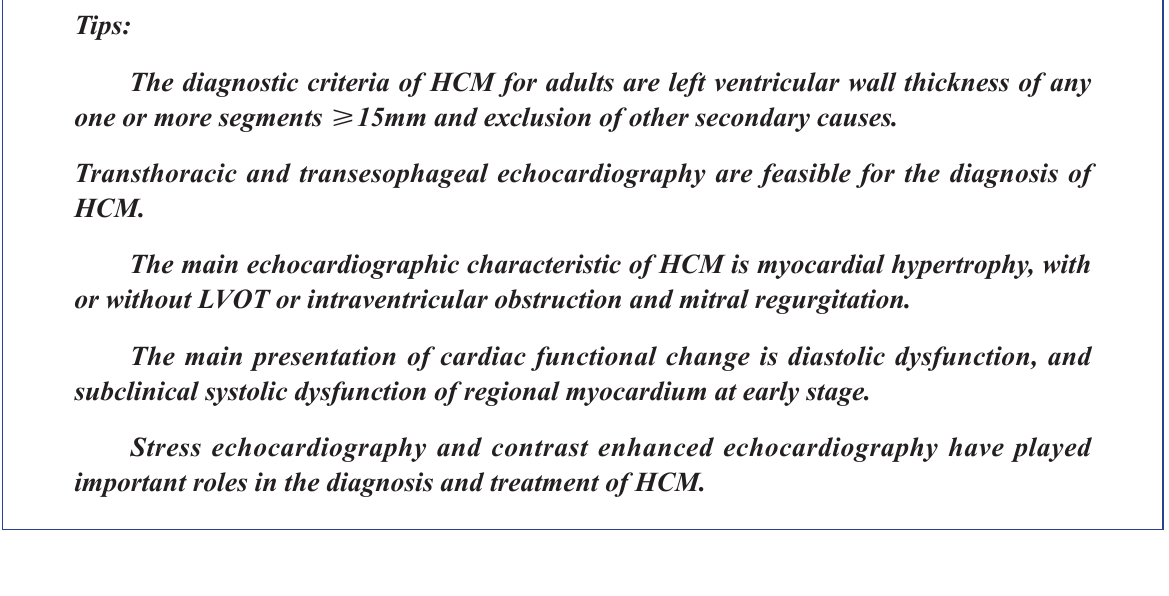
Table 2 Classification of RCM